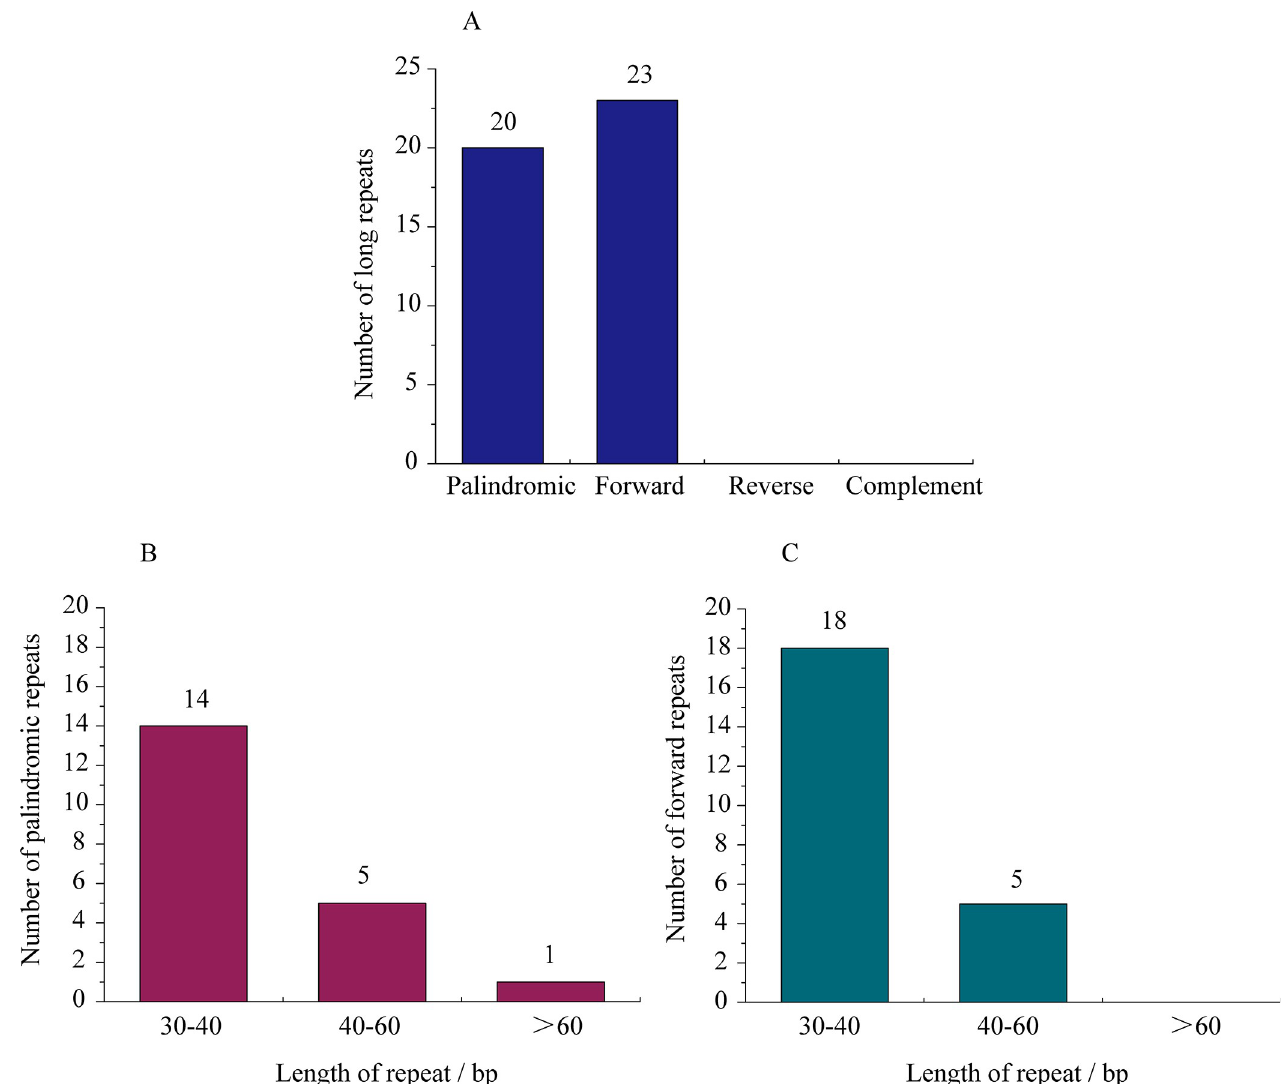
Fig 3. Analysis of identified long repeat sequences in I . dabieshanensis chloroplast genome. A) Number of long repeats in four identified types; B) Number of palindromic repeats by length; and C) Number of forward repeats by length.